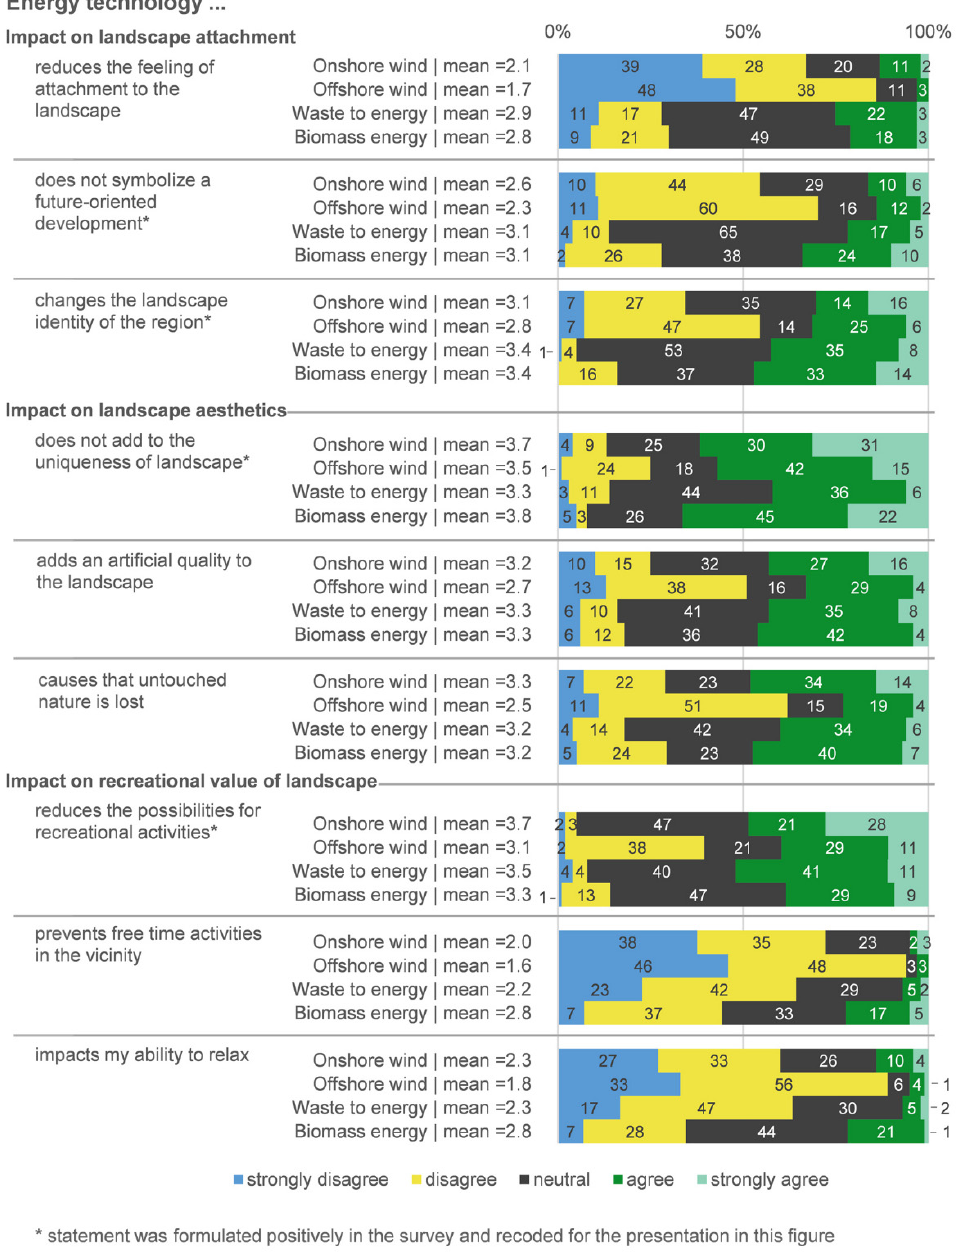
Figure 5. Experienced impact on landscape quality in the energy neighborhoods in % per survey group. For the calculation of the mean value, a scale from 1: strongly disagree to 5: strongly agree was used.